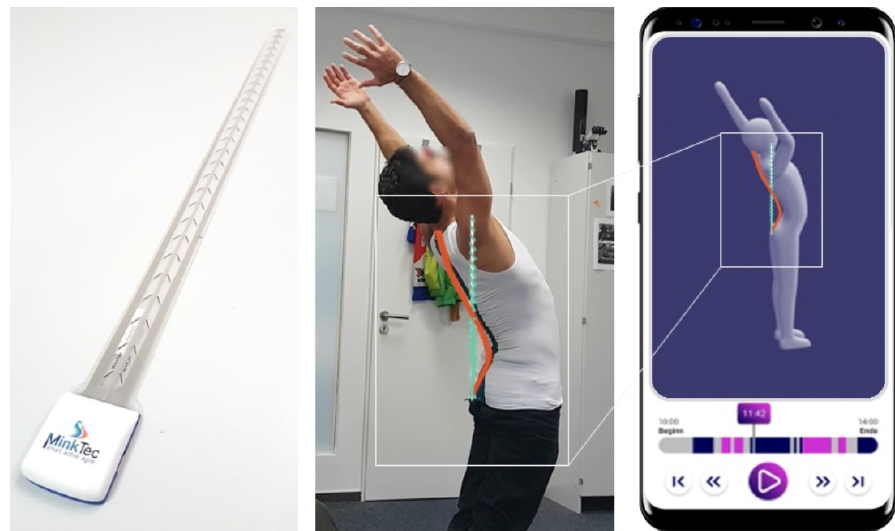
Figure 1. From left to right: Flexible wearable device, a subject wearing the wearable device, and the corresponding subject’s movements on a Minktec mobile application. The sensor’s strip can be bent to form a complete